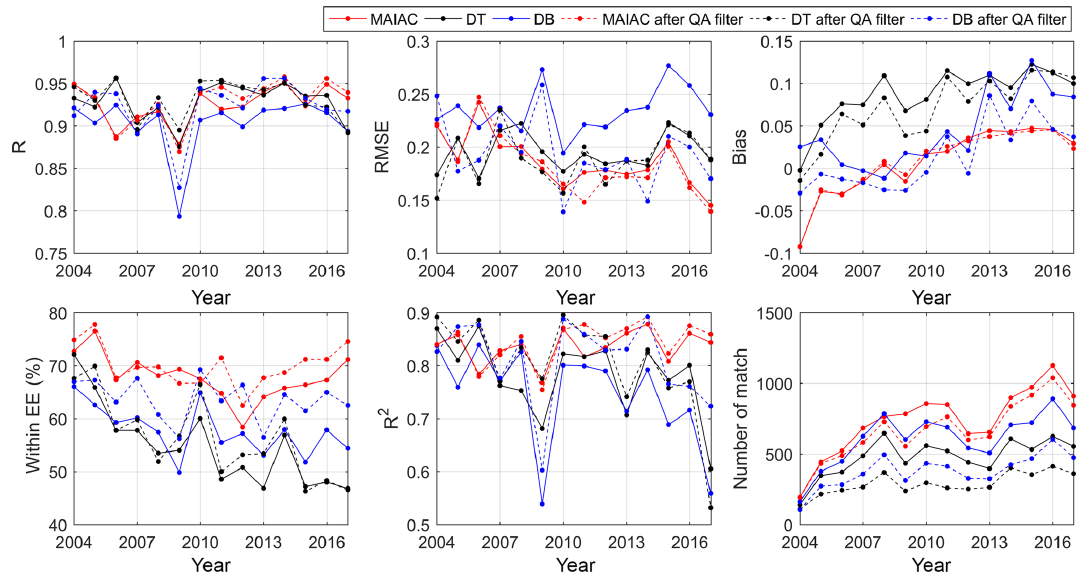
Figure 11. Validation of MAIAC, DT, and DB in different years before and after the QA filter from 2004 to